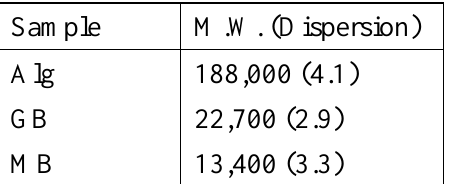
Table 1: Molecular weight of alginate and the hydrlysates.